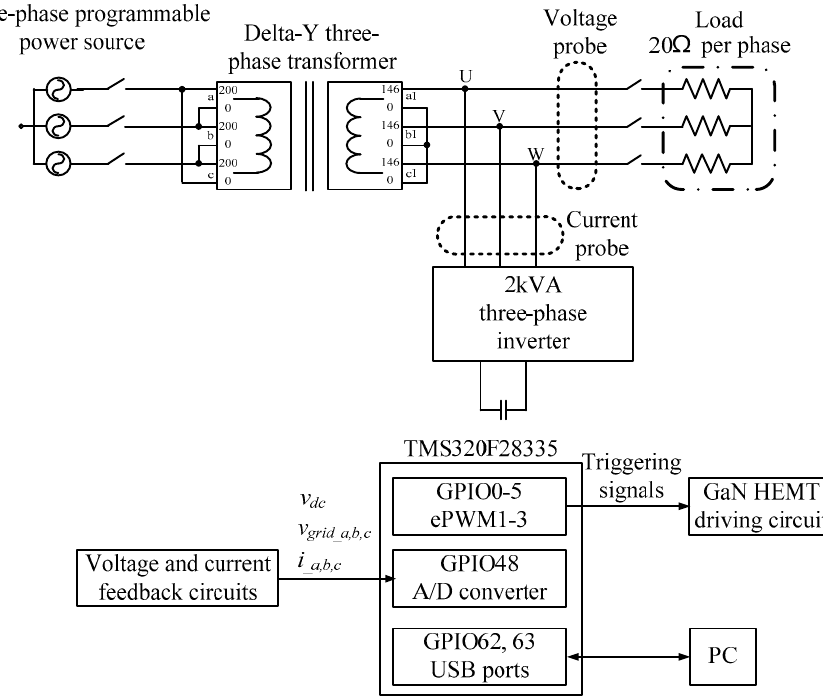
Figure 22. Conceptual diagram of the hardware implementation system. Table 4. Specifications and parameters of hardware implementation.